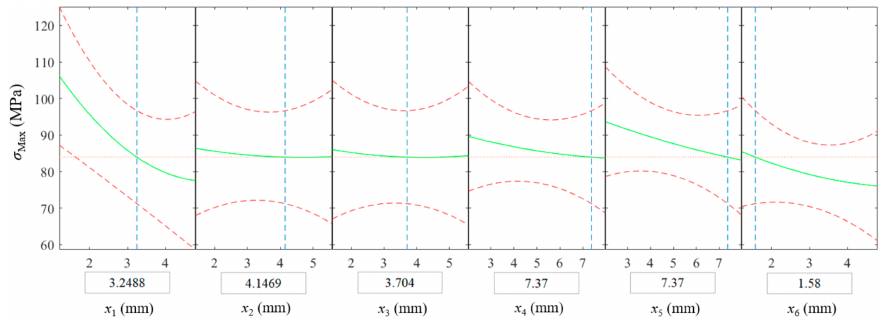
Figure 12. Influence of the design variables on the maximum